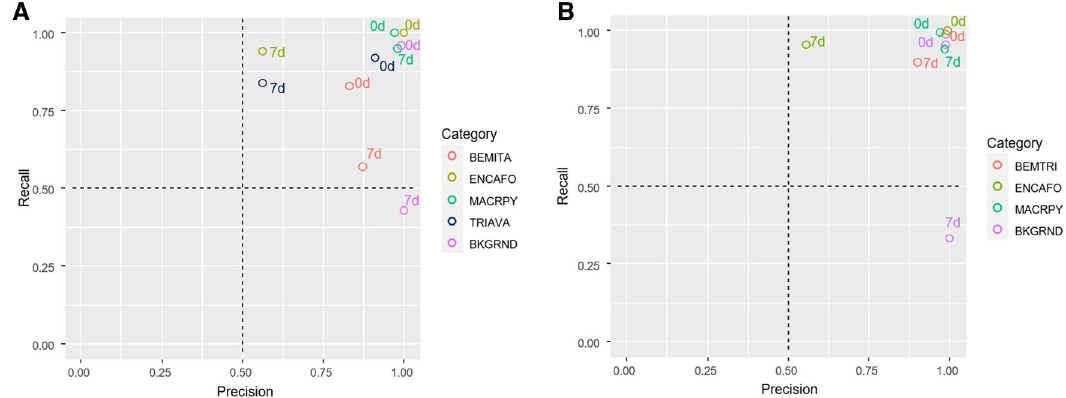
Figure 1. Recall-precision plots for ( A ) model 164 with no categorical pooling and ( B ) with categorical pooling. 7d = Lab7d dataset, 0d = Lab0d dataset, BEM-TRI = pooled class of B. tabaci and T. vaporariorum. The graphs were generated using ggplot in R 20,21